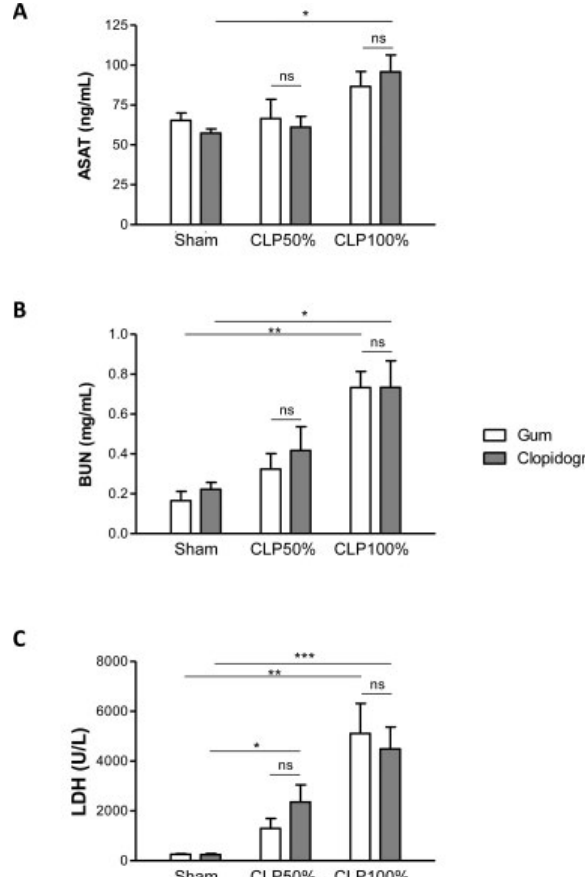
Fig. 5 Clopidogrel treatment does not protect mice from sepsis- induced organ damage. Plasma levels of aspartate aminotransferase (ASAT) ((A)), blood urea-nitrogen (BUN) ((B)) or lactate dehydroge- nase (LDH) ((C)), in clopidogrel- or vehicle-treated mice, 20hours after mid- or high-grade form of CLP as compared with sham-surgery. Results are presented as the mean (cid:4) SEM ( n ¼ 6 – 7, (cid:1)(cid:1)(cid:1) p < 0.001, (cid:1)(cid:1) p < 0.01, (cid:1) p < 0.05, ns p >